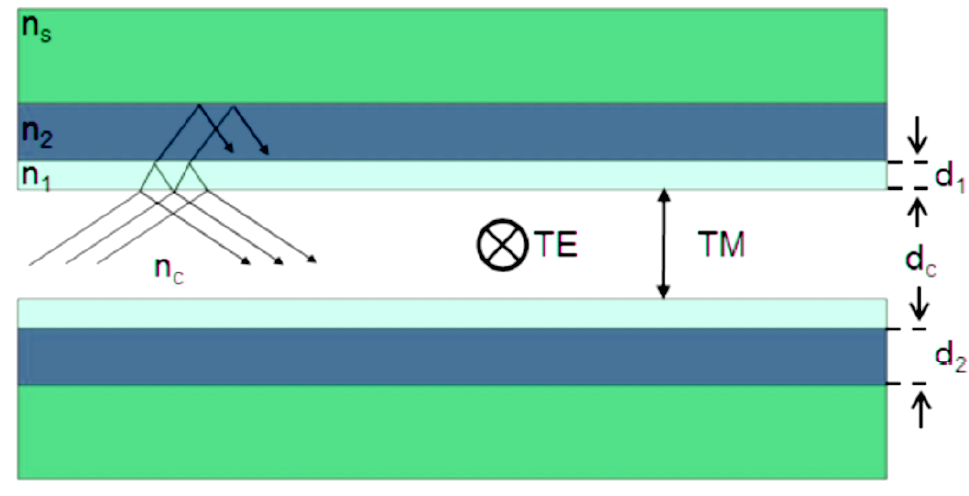
Figure 14. 1D structure of narrow waveguide.